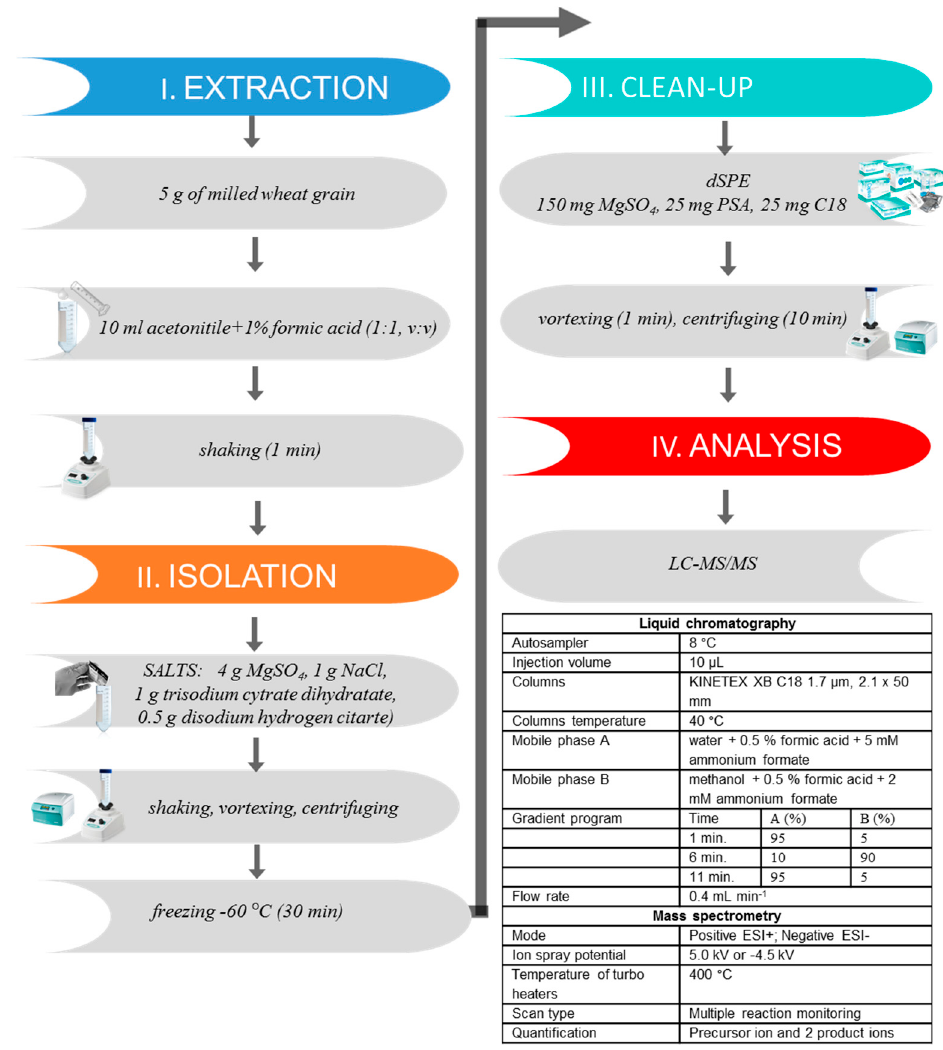
Figure 1. Scheme of wheat grain sample preparation, extraction, and analysis of mycotoxins using LC–MS/MS.